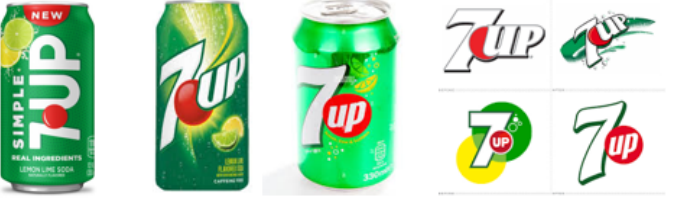
Figure 2. Same brand with a different appearance and orientation. Logos extracted from LogoDet-3K dataset